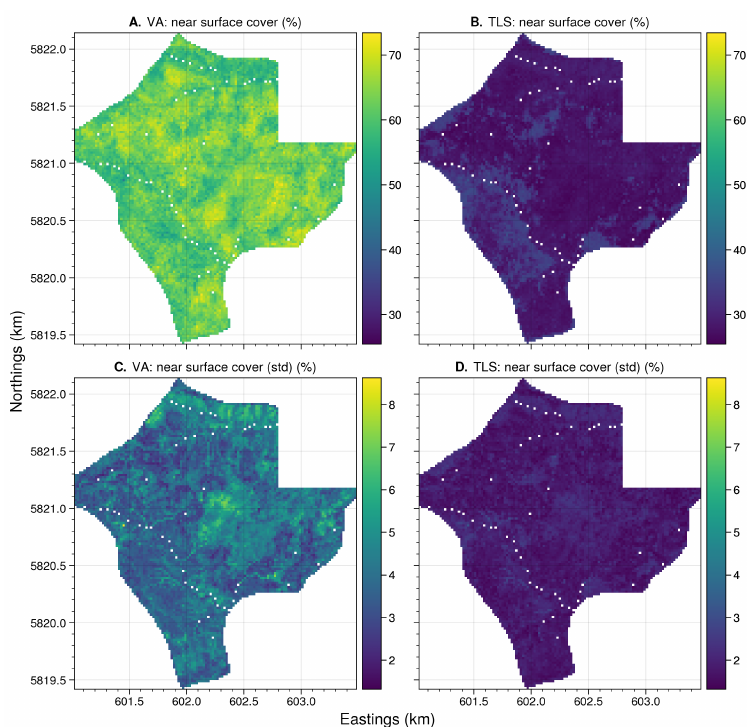
Figure A16. The mean and standard deviation of landscape-level predictions for near-surface fuel cover using visual assessments ( A , C ) and TLS ( B , D ) at